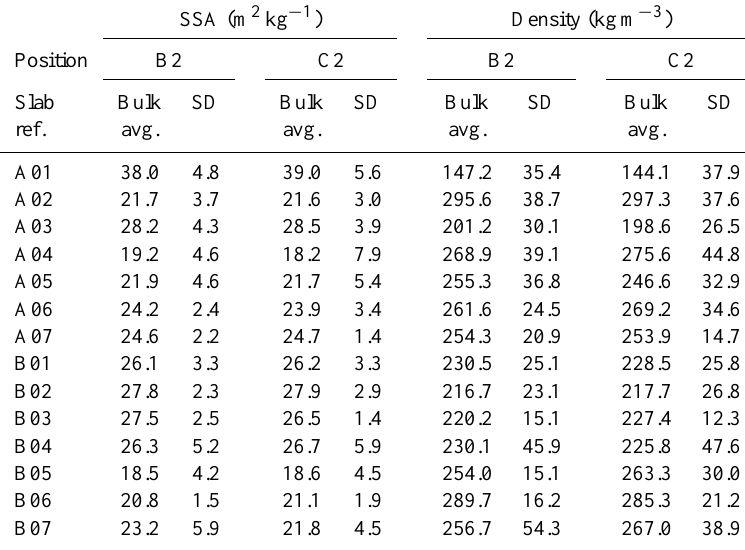
Table 5. Locally calibrated SMP-derived bulk average and standard deviation values of SSA and density. The values for B2 and C2 correspond to positions B2 and C2 in Fig.